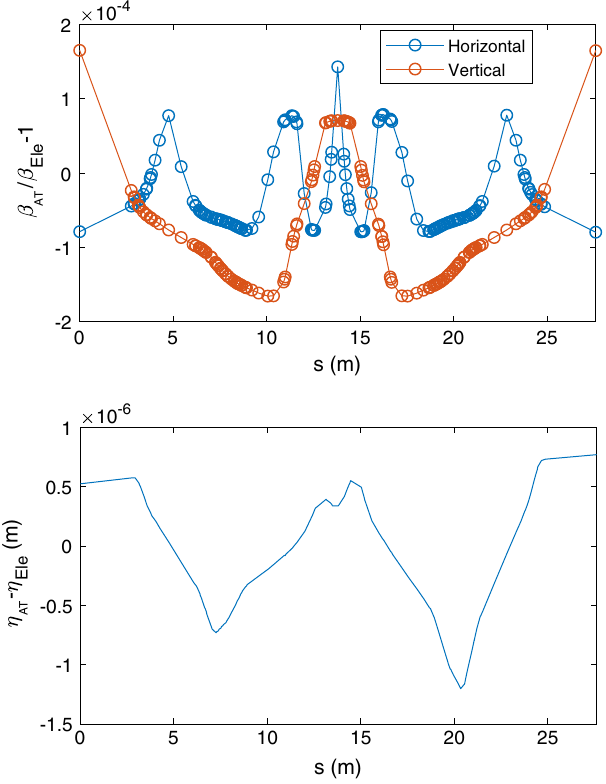
FIG. 5. Differences in linear optics functions between AT and ELEGANT for a sector of the APS-U lattice. Top: fractional beta function difference; bottom: dispersion